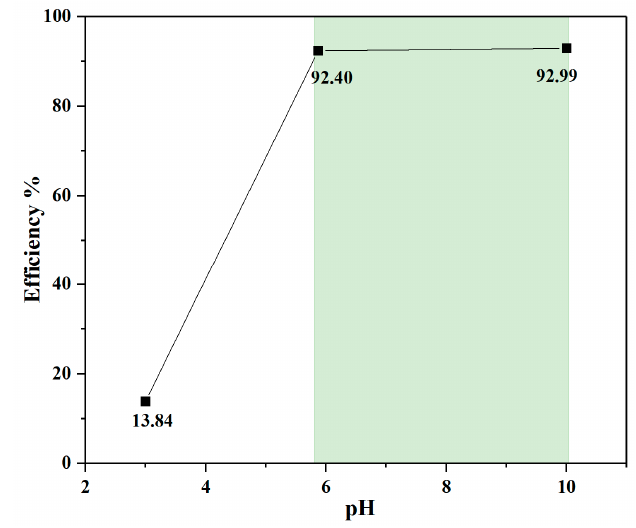
Figure 10. The pH study on the Tl(I) removal efficiency using NOCNF (0.32 wt%).